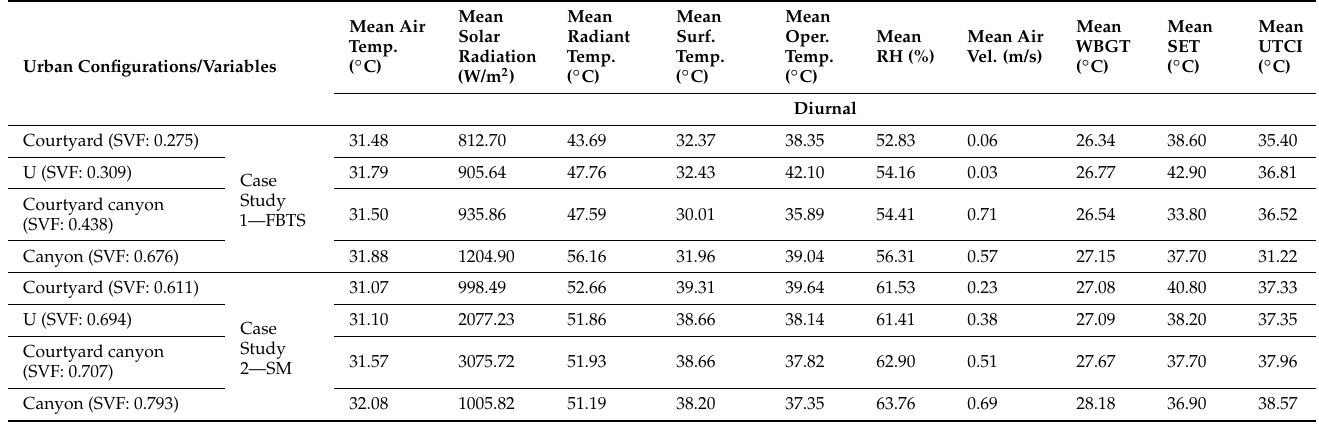
Table 5. Mean diurnal and nocturnal values of environmental variables and thermal indices for various urban configurations in the case studies.